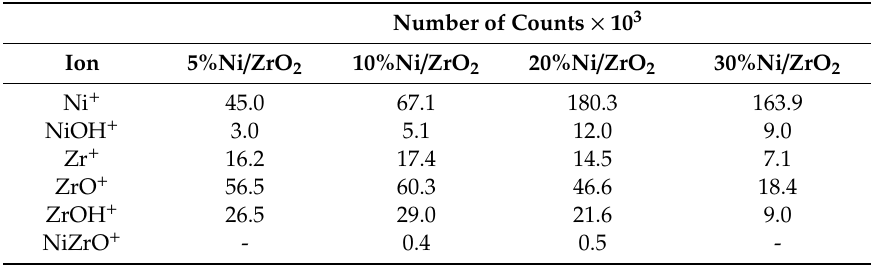
Table 6. TOF-SIMS results obtained for spent Ni catalysts supported on ZrO 2